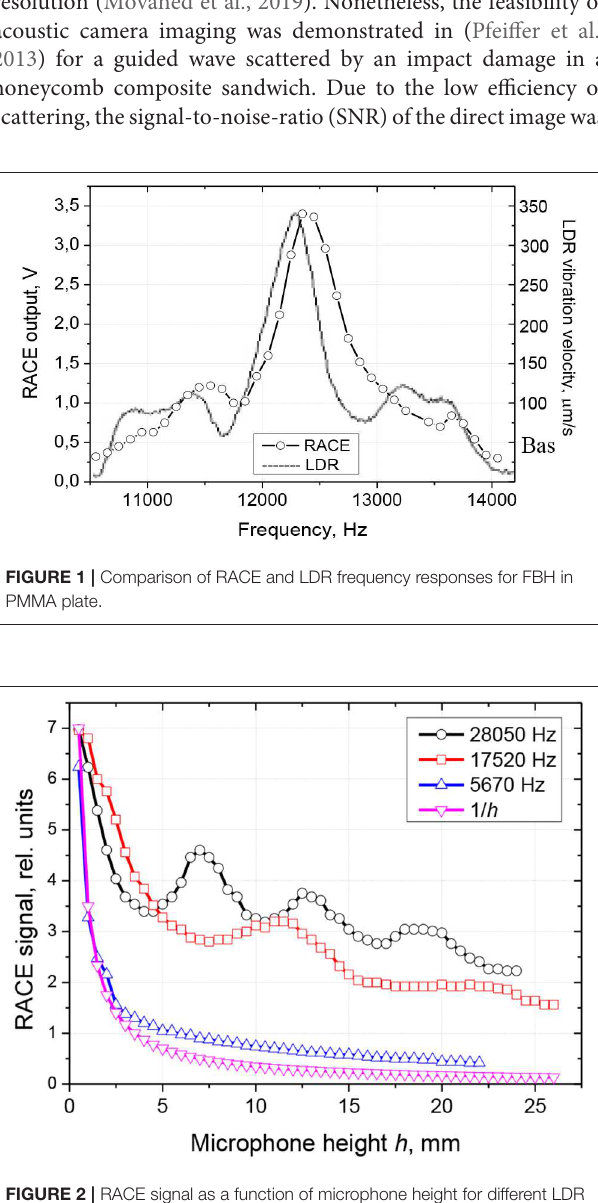
FIGURE 2 | RACE signal as a function of microphone height for different LDR frequencies.